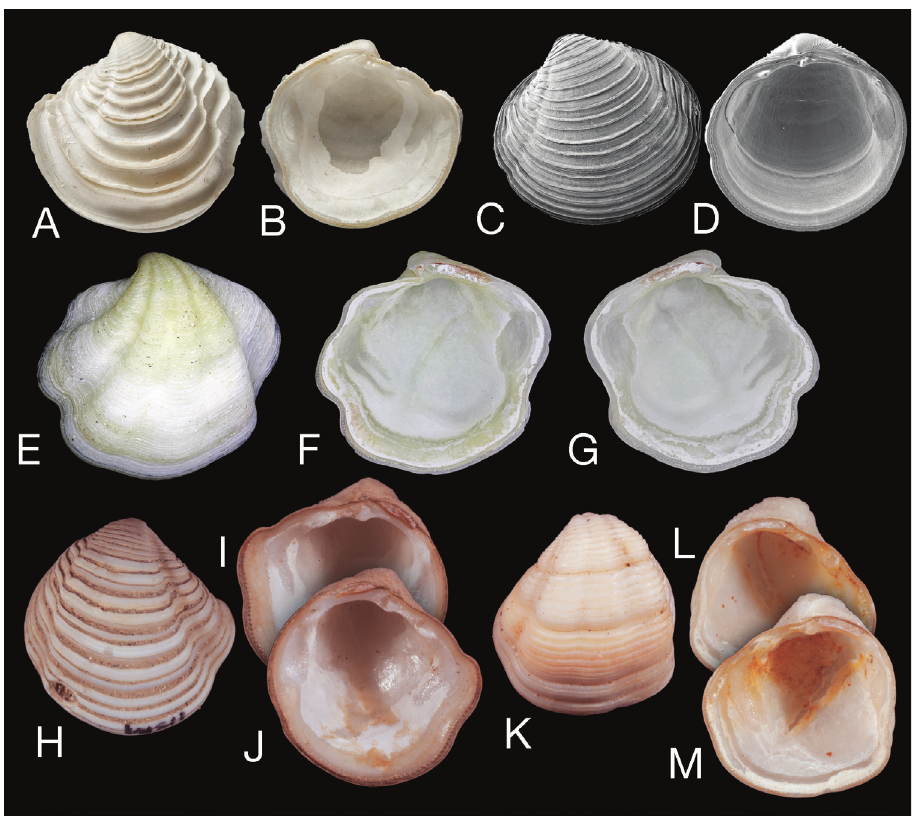
Figure 9. Other Pleurolucina species. A , B Pleurolucina hendersoni Britton, 1972, exterior and interior of left valve Guadeloupe station GD 69 (MNHN), L 9.1 mm C , D Pleurolucina sombrerensis (Dall, 1886) exte- rior of left valve (L 4.9 mm) and interior of right valve (L 5.2 mm), USNM 446178, Eolis stn 48, off Miami, Florida, 110 m E–G Pleurolucina undata (Carpenter, 1865) exterior of left valve and interiors of right and left valves, NUMUK 1915.15.273 ‘California’, L 11.0 mm H–J Pleurolucina leucocymoides (Lowe, 1935), exterior of right valve and interiors of right and left valves SBMNH 141511, Baja California, NE of Isla Dan- zante, Mexico, L 11 mm K–M Pleurolucina taylori Coan & Valentich-Scott, 2012, holotype, exterior of left valve and interior of left and right valves, SBMNH 149647, Baja California, Los Frailes, Mexico, L 9.5